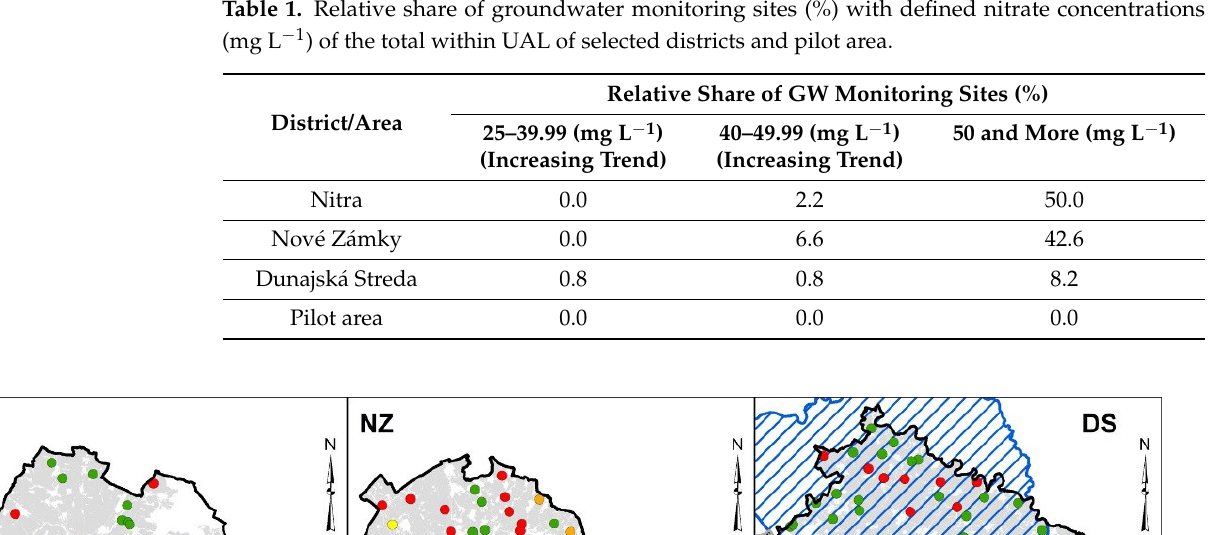
Figure 2. Spatial distribution of defined average nitrate concentrations in groundwater in 2016–2019 within selected districts and pilot area. Table 1. Relative share of groundwater monitoring sites (%) with defined nitrate concentrations (mg L −1 ) of the total within UAL of selected districts and pilot area.